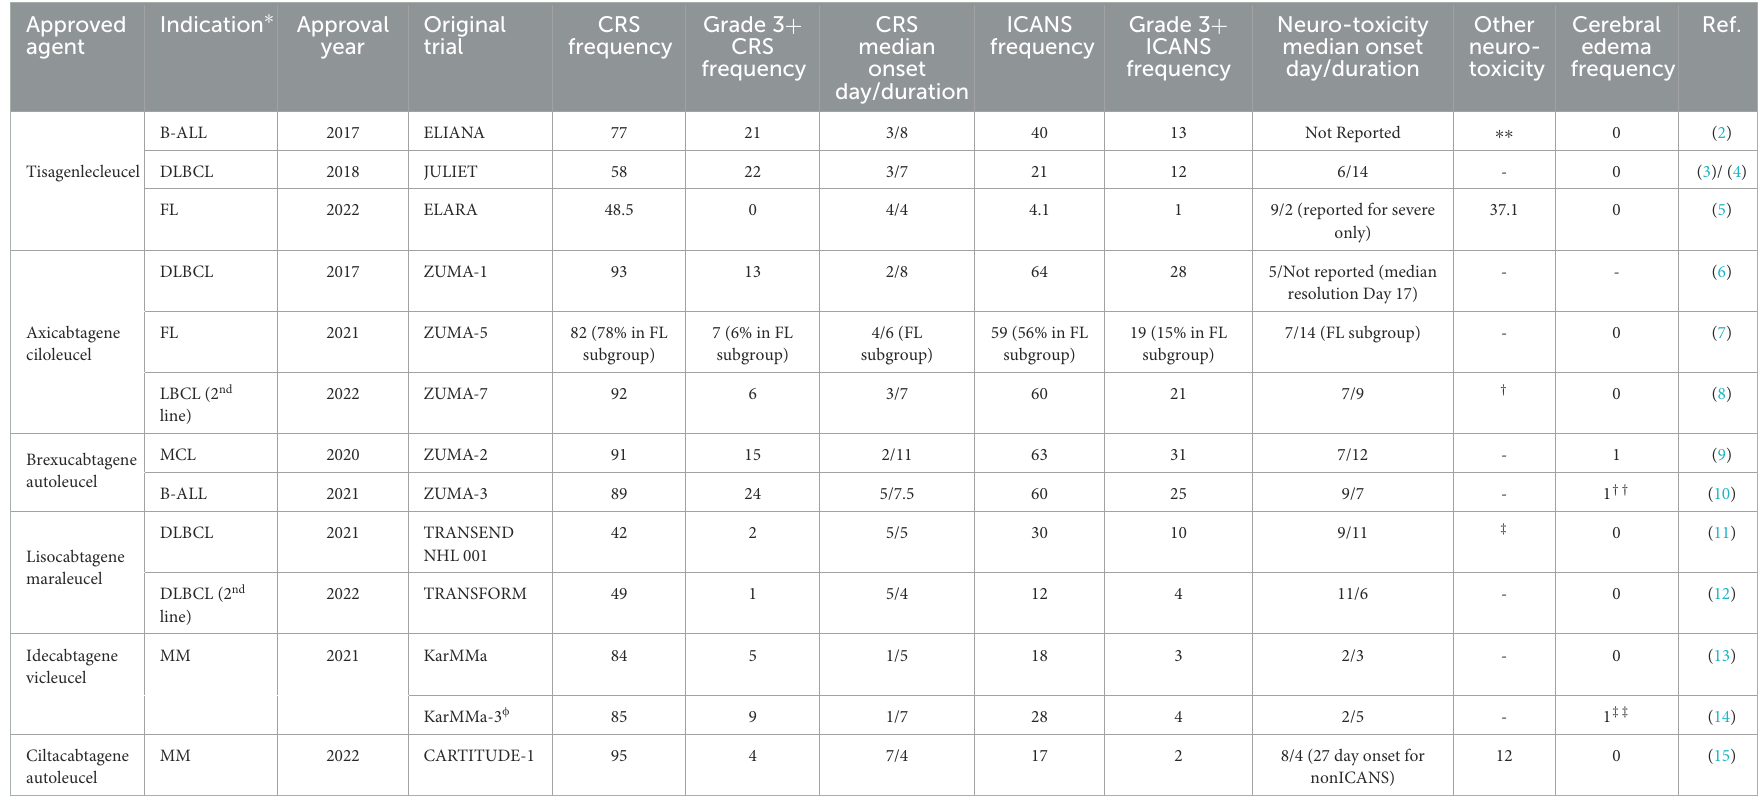
TABLE 1 FDA-approved cellular therapy: frequency of neurotoxicity and related adverse